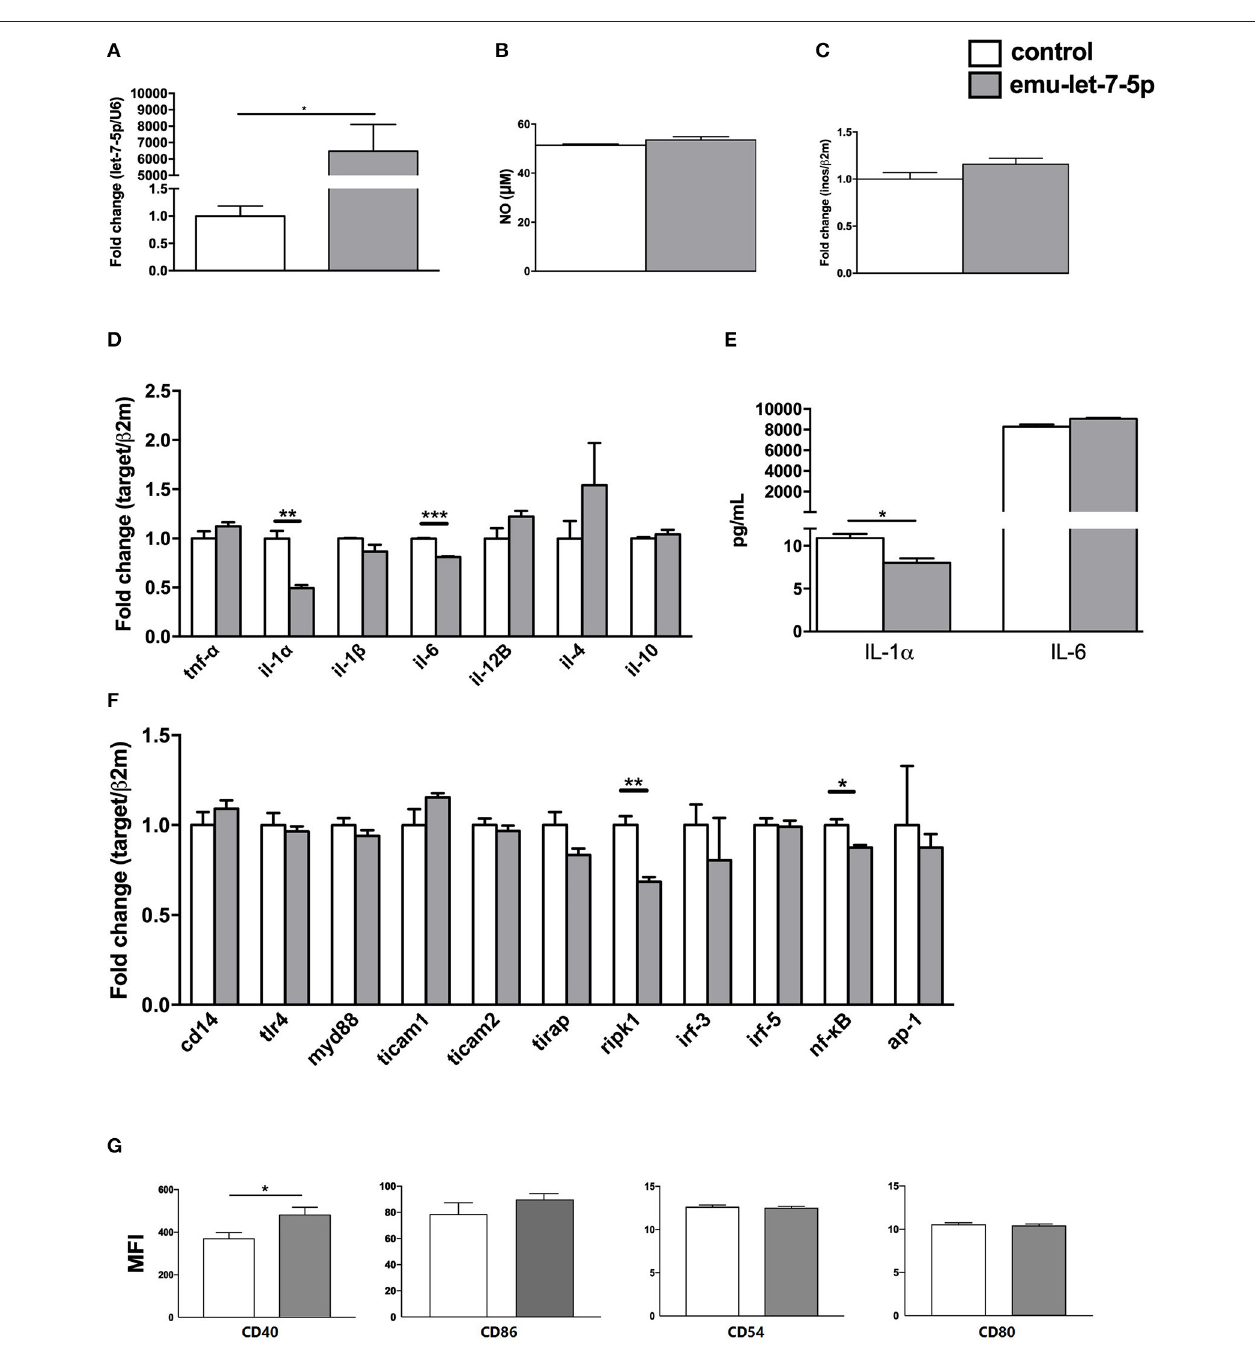
FIGURE 1 | Immunomodulatory effects of emu-let-7-5p in the transfected RAW264.7 macrophages. (A) qPCR analysis of the levels of emu-let-7-5p in mimics-transfected cells. Data are expressed as mean ± s.e.m; * p < 0.05. Data for the final analysis are from three independent experiments. (B) NO secretion post transfection with emu-let-7-5p. Data are expressed as mean ± s.e.m. Data for the final analysis are from three independent experiments. (C) qPCR analysis of inos expression post transfection with emu-let-7-5p. Data are expressed as mean ± s.e.m. Data for the final analysis are from three independent experiments. (D) qPCR analysis of the expression of pro- and anti-inflammatory cytokine genes post transfection with emu-let-7-5p. Data are expressed as mean ± s.e.m; ** p < 0.01, *** p < 0.001. Data for the final analysis are from three independent experiments. (E) Determination of IL-1 α and IL-6 levels by ELISA. Data are expressed as mean ± s.e.m; * p < 0.05. Data for the final analysis are from three independent experiments. (F) qPCR analysis of the expression of key components in the LPS/TLR4 signaling pathway post transfection with emu-let-7-5p. Data are expressed as mean ± s.e.m; * p < 0.05, ** p < 0.01. Data for the final analysis are from three independent experiments. (G) Flow cytometry of the expression of CD40, CD86, CD54 and CD80 post transfection with emu-let-7-5p. Data are expressed as mean ± s.e.m; * p < 0.05. Data for the final analysis are from three independent experiments. MFI, mean fluorescence intensity.